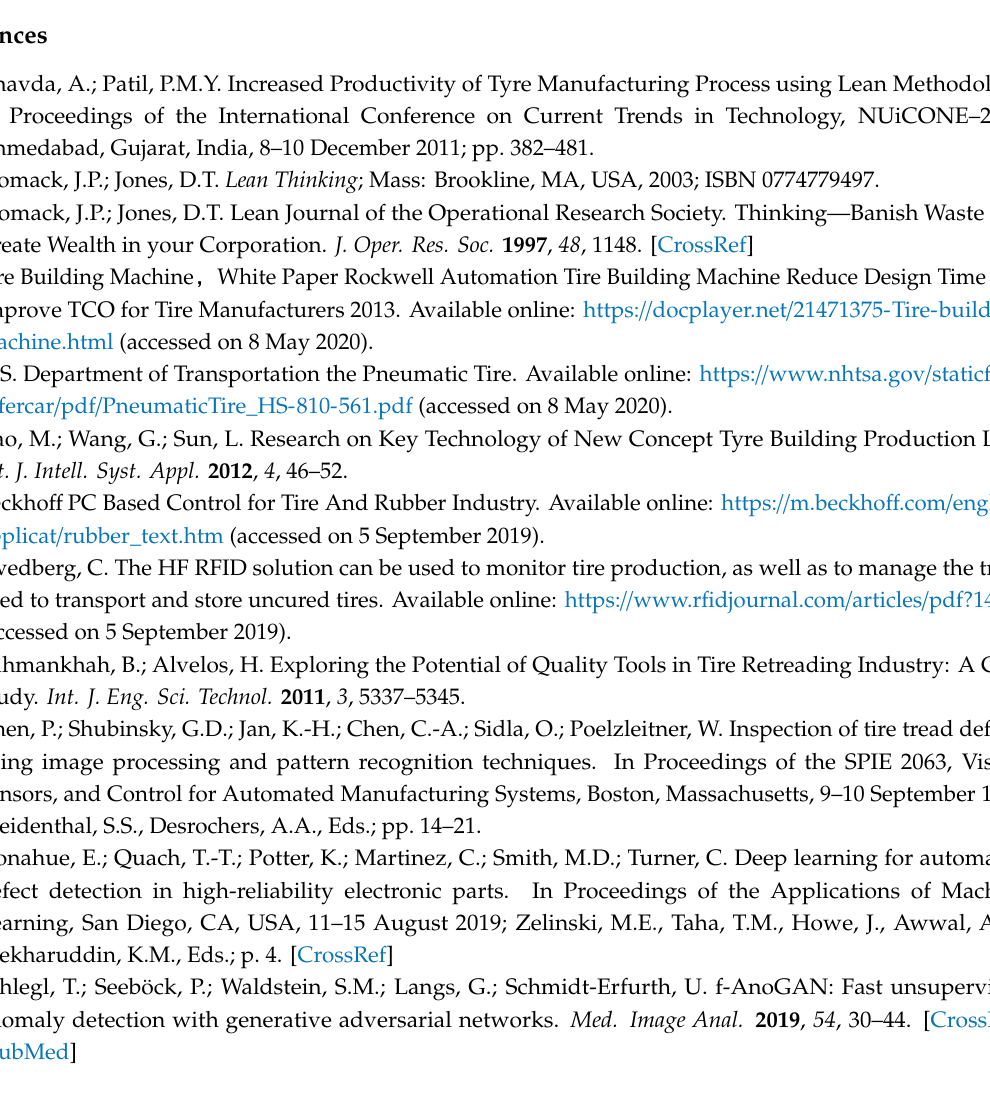
Figure A2. Cluster error versus the iteration number (for K = 5) for the di ff erent images in the